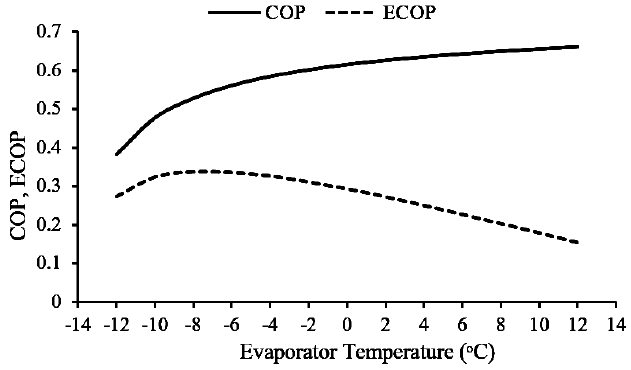
Figure 19. Effects of T eva on COP and ECOP.